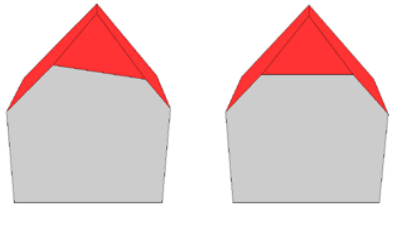
Figure 5. Reconstructed building model before (left) and after the local half-space adjustment step